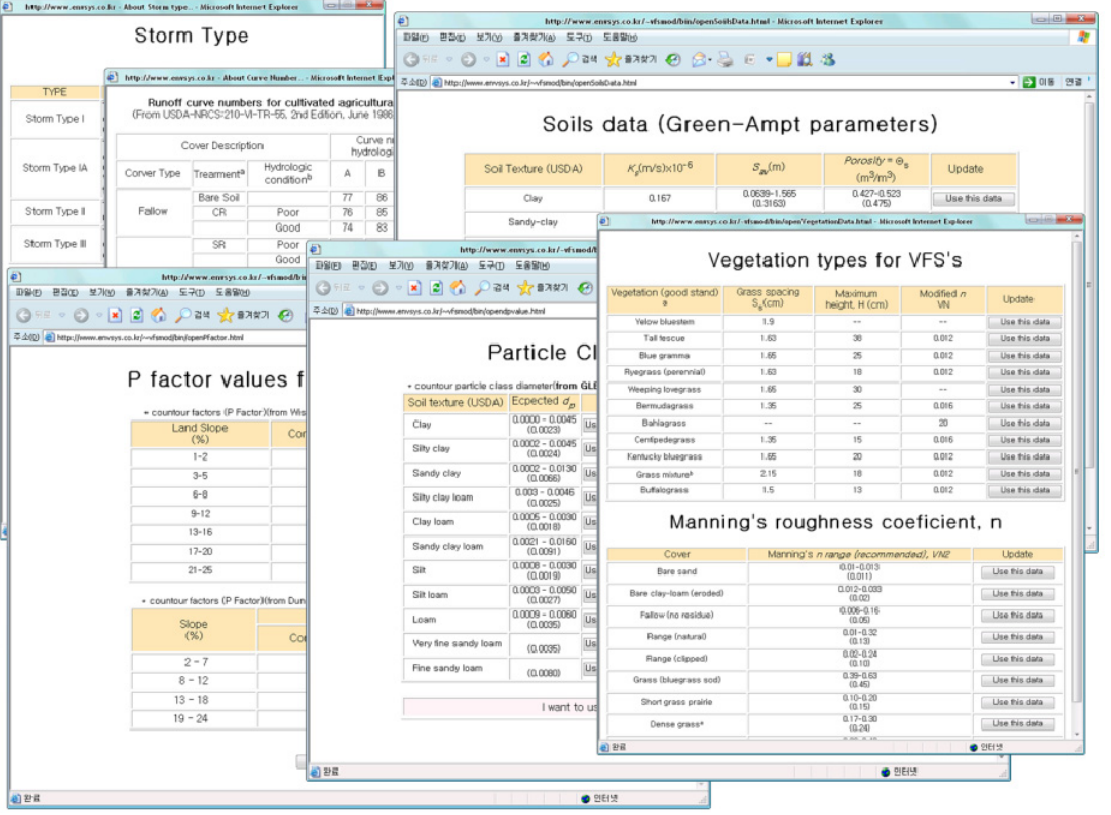
Figure 4. HTML reference tables for various input